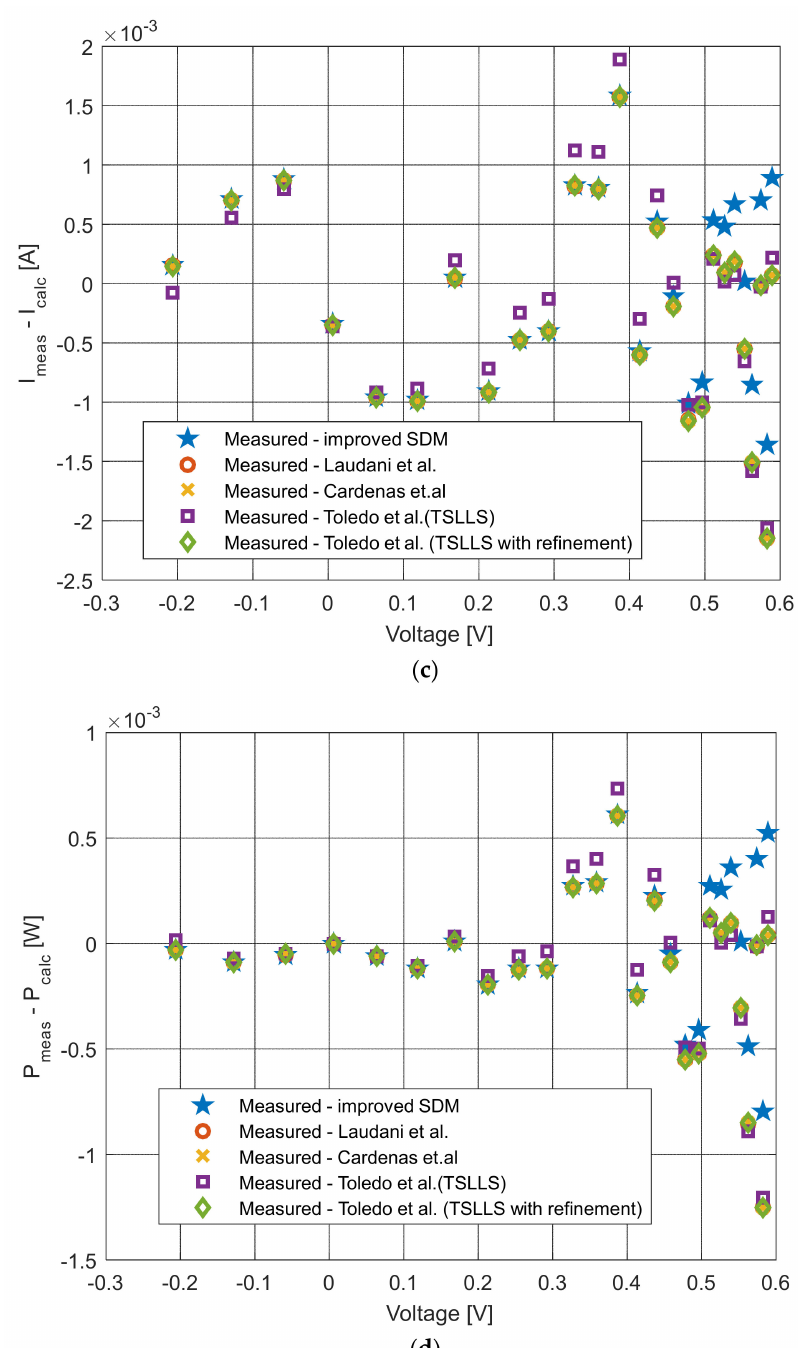
Figure 14. Comparison with the deterministic methods described in [63–66] for the RTC France solar cell using different methods for both SDM and ISDM: ( a ) current–voltage characteristics, ( b ) power– voltage characteristics, ( c ) difference between the measured and calculated current values, and ( d ) difference between the measured and calculated power